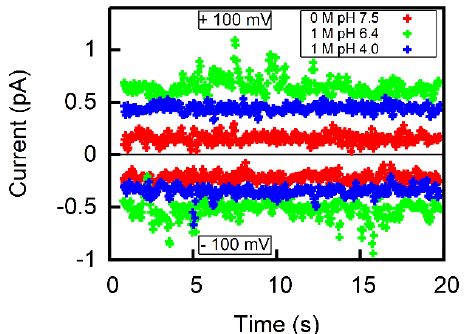
Figure 4. Representative current traces for ± 100 mV applied to freestanding lipid bilayers of comparable sizes (diameter of aperture 395.5 µ m) in the absence of Na-Asc at pH 7.5 (red) and in the presence of 1 M Na-Asc at pH 6.4 (green) and at pH 4.0 (blue). The aqueous solution contained 100 mM NaCl and 10 mM HEPES. If all conductivity is attributed to Asc − , one obtains an upper limit for P − on the order of 3 × 10 − 12